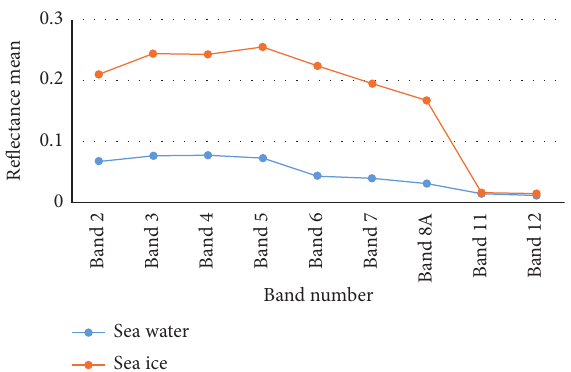
Figure 5: Comparison of reflectivity in different bands of seawater and sea ice.